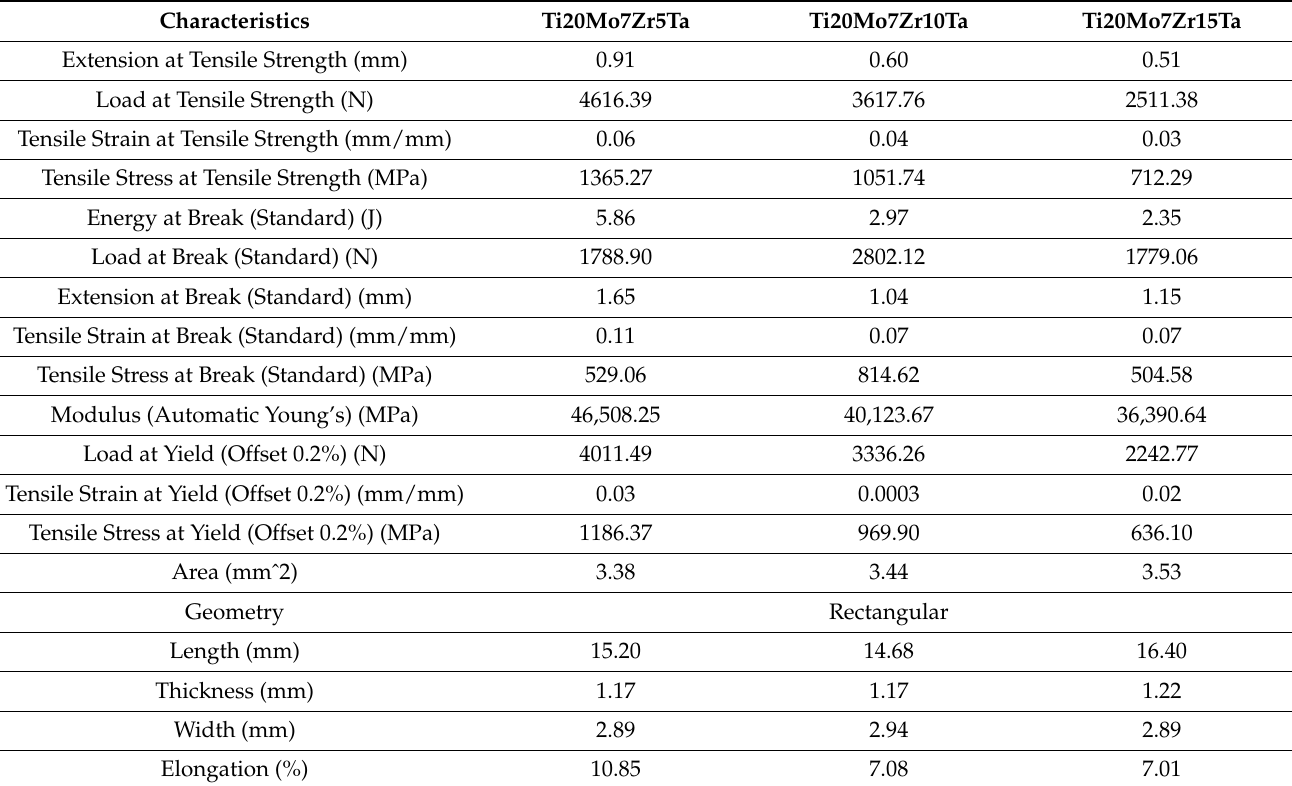
Table 1. Summary of tensile properties on investigated